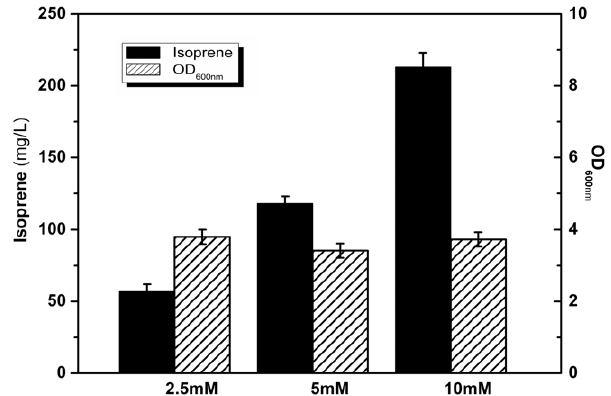
Figure 3. Isoprene production of Strain YJM12. The strain was cultured supplemented with different concentrations of mevalonate under flask conditions. The experiment was done in triplicate.